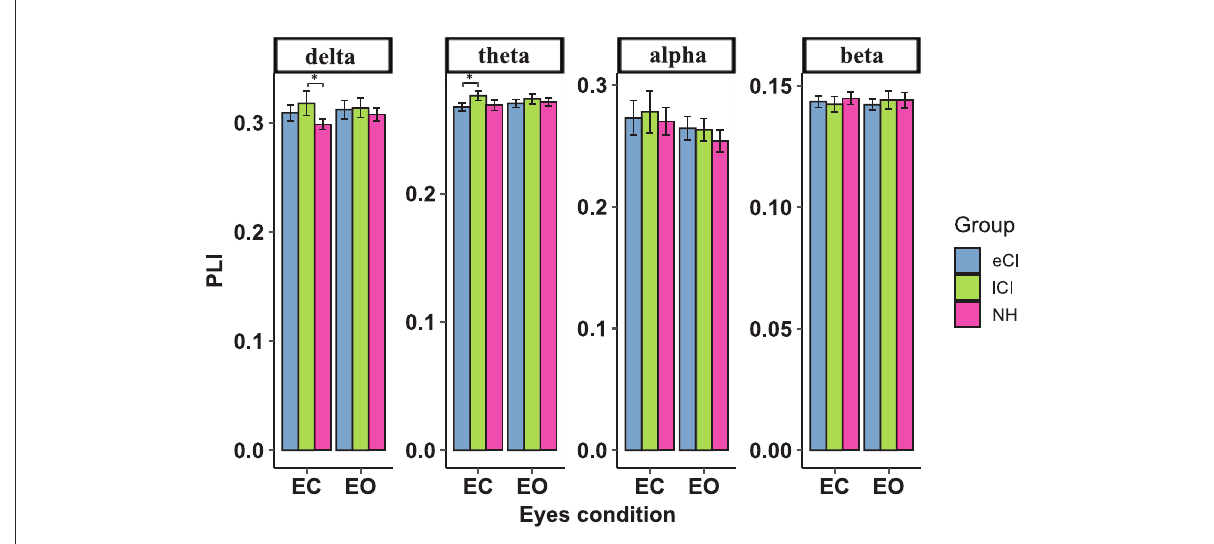
FIGURE5 Functional connectivity between the right temporal region and right occipital region. The average functional connectivity between the right temporal region and right occipital region was defined by the phase lag index (PLI) (y-axis) under the eyes-closed (EC) and eyes-open (EO) conditions (x-axis) in the delta, theta, alpha, and beta frequency bands (top) in children with early cochlear implantation (eCI), children with late cochlear implantation (lCI) and children with normal hearing (NH). Interactions of eyes condition and group were found in the delta and theta bands. In the delta band, lCI children had higher PLI values than NH children, and in the theta band, lCI children had higher PLI value than either eCI or NH children. ∗ p <